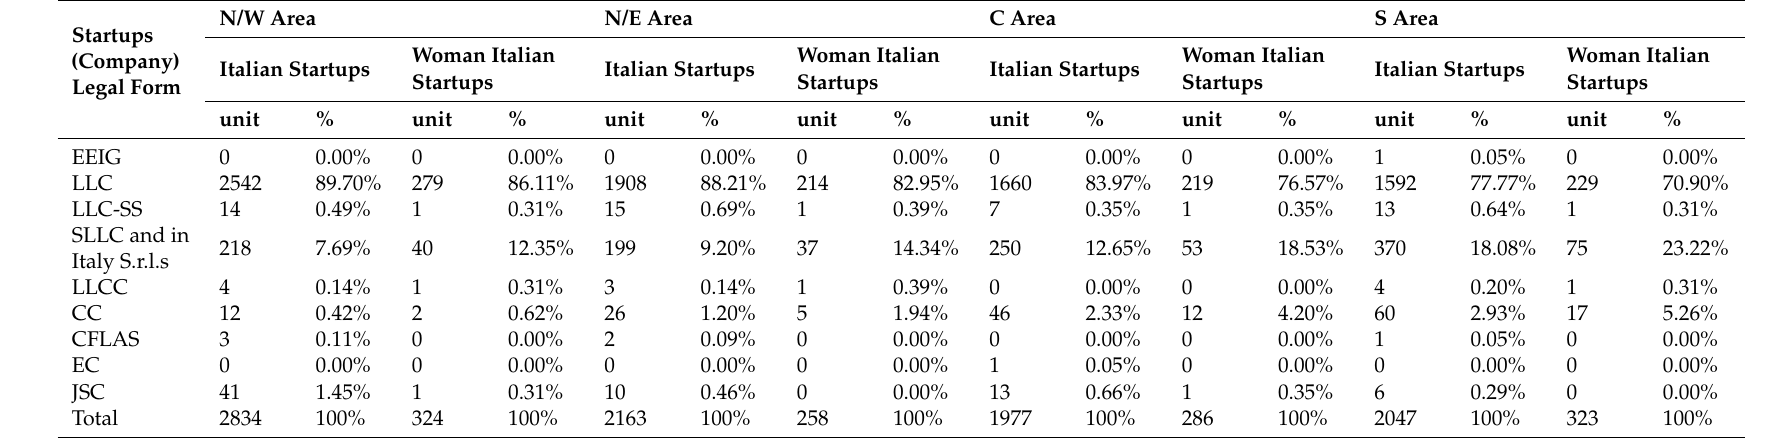
Table 7. Legal form of Italian startups and Italian woman startups for geographical